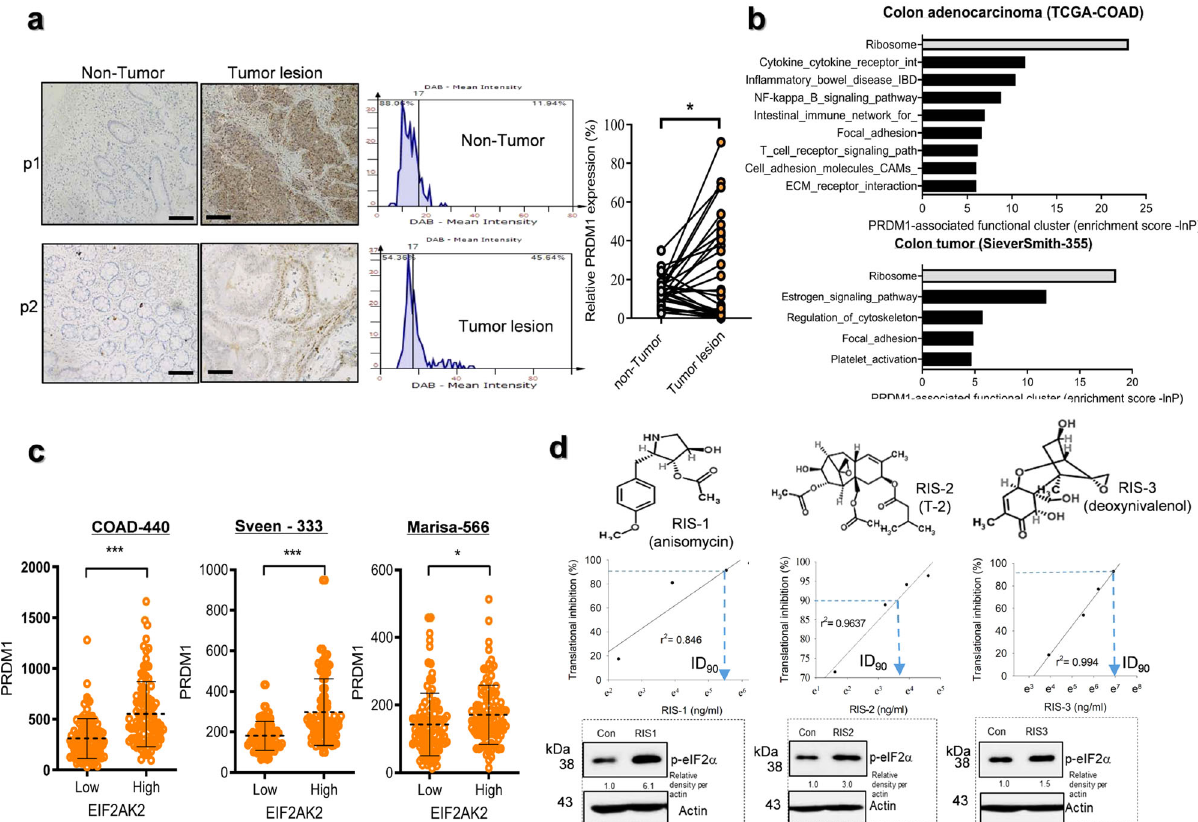
Fig. 3 PRDM1 expression and ribosomal stress in CRC. a PRDM1 immunohistochemistry (IHC) of normally appearing parts (left) and tumor lesions (right) from each patient with quanti fi cation of PRDM1 staining from IHC analysis using Histo-quest software 4.0 (the mid histograms). All patients ’ quantitation was statistically analyzed (the right graph). Asterisks indicate a signi fi cant difference compared to each non-tumor lesion based on the paired t- test ( n = 30, P < 0.05). The microscopy analysis was performed at original magni fi cation ×200; scale bar(s), 50 μ m. b KEGG-based functional annotations of PRDM1-related genes in CRC patients (TCGA COAD ( n = 286, upper graph), and SieverSmith (gse14333 and gse17538, n = 355, lower graph)). PRDM1- associated genes in CRC patients were selected using the correlation analysis (R cutoff = absolute 0.5) and HugoOnce algorithm. Selected genes were clustered based on KEGG pathway analysis ( P < 0.05) and the enrichment score was described as values of − ln(P). c Expression of PRDM1 was assessed in patients with CRC (TCGA-COAD, n = 440; Sveen ’ s, gse24551, n = 333; Marisa ’ s, gse39582, n = 566). Based on EIF2AK2 levels, we chose the 100 highest and 100 lowest level samples, which were further compared for levels of PRDM1 . Results are shown as mean values± SD and asterisks ( ∗ ) indicate signi fi cant differences from the low expression group (* P < 0.05, *** P < 0.001). d Chemical structures of RIS-producing agents (upper panels). HCT-8 cells were treated with serial concentrations of RIS for 24 h, and changes in total protein synthesis per a cell from 0 to 24 h were measured (middle graphs). The additional translational arrest was veri fi ed by detecting p-eIF2 α levels in the ribosome-inactivated cells (lower panels for western blot